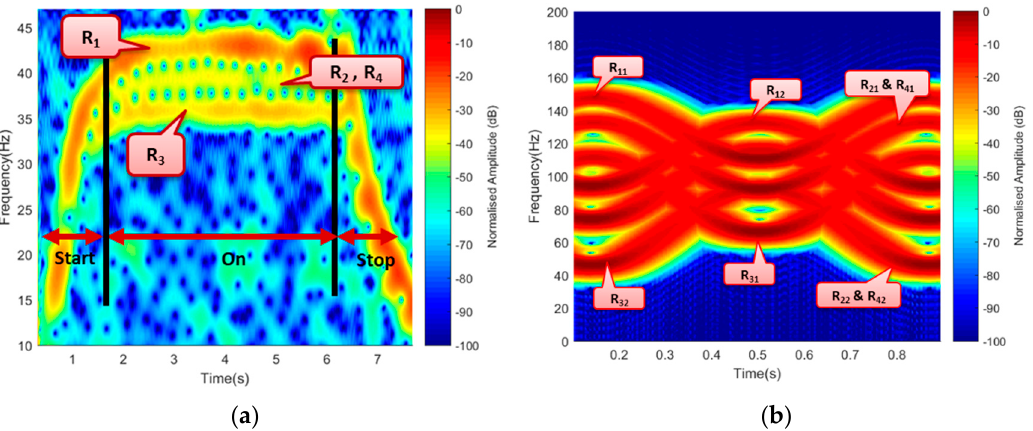
Figure 7. A 4-rotor, 2-blade ( a ) Experimental and ( b ) simulated Doppler.